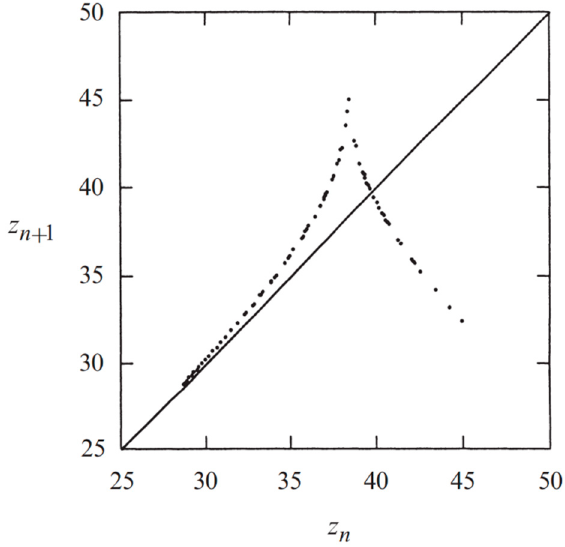
Figure 4. The Lorenz map reflects the feature of the nonlinear response in Figure 3 visually. This